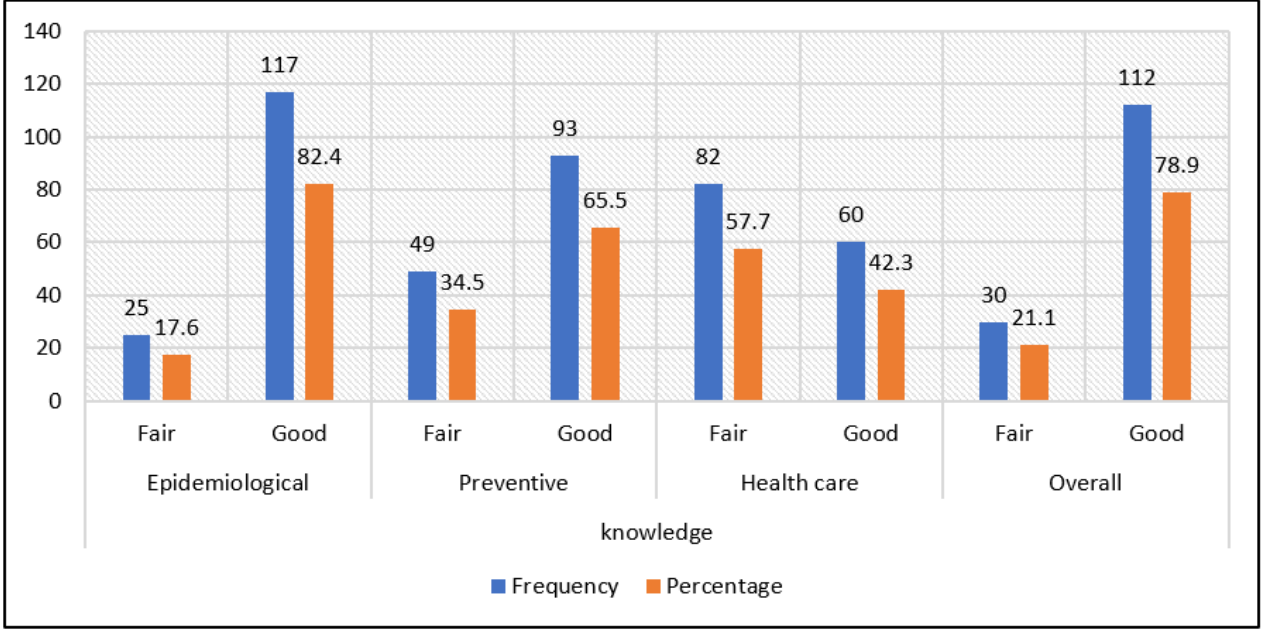
Figure 1. Frequency of epidemiological, preventive, health care and overall knowledge of dentists from DIRIS Lima Norte about